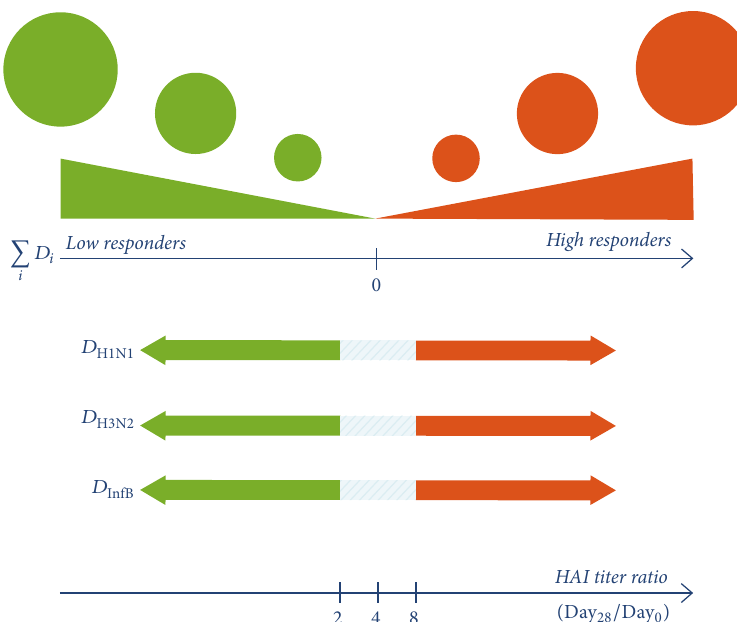
Figure5: Rationaleforthecomputationofthetiterresponsescore. Thescoreintegratestheresponsesobtainedwiththethreestrainsrepresented in the TIV (H1N1, H3N2, and influenza B) by summing the logarithmic deviations of the HAI Day 28/ Day 0 ratios from the threshold value of the class to which the subject belongs (2 for low responders, 8 for high responders). The circles of different radius on the top of the figure represent how the TRS was encoded as node size in Figure